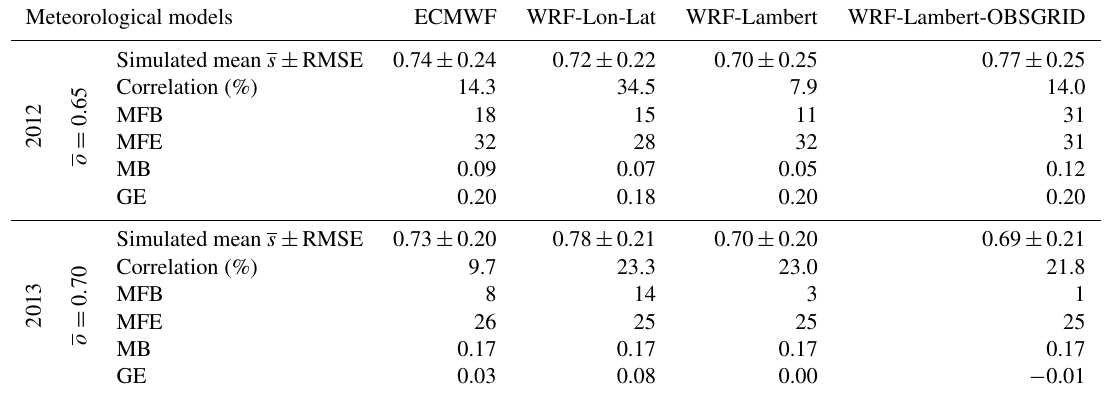
Table 6. Relative humidity statistics for the four meteorological models at Ersa during the 2012 and 2013 summers. The relative humidity means and the RMSEs are dimensionless. o refers to the measured